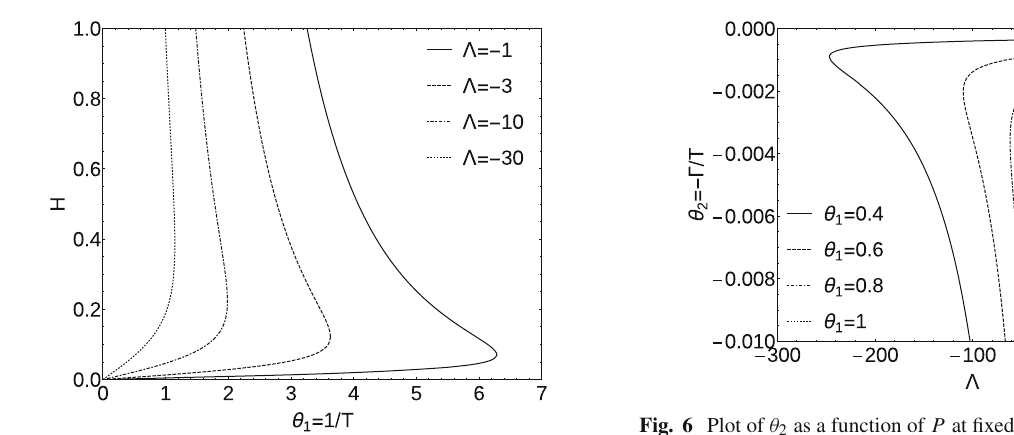
Fig. 5 Plot of H as a function of θ 1 = 1 / T at Γ = const series of H (θ 1 ) with fixed Λ has a vertical tangent when S c = 4 / 3.